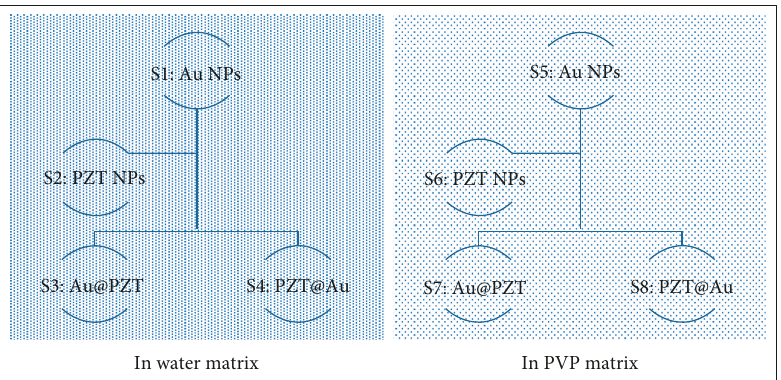
Figure 2: The steps to prepare the core-shell nanoparticles for